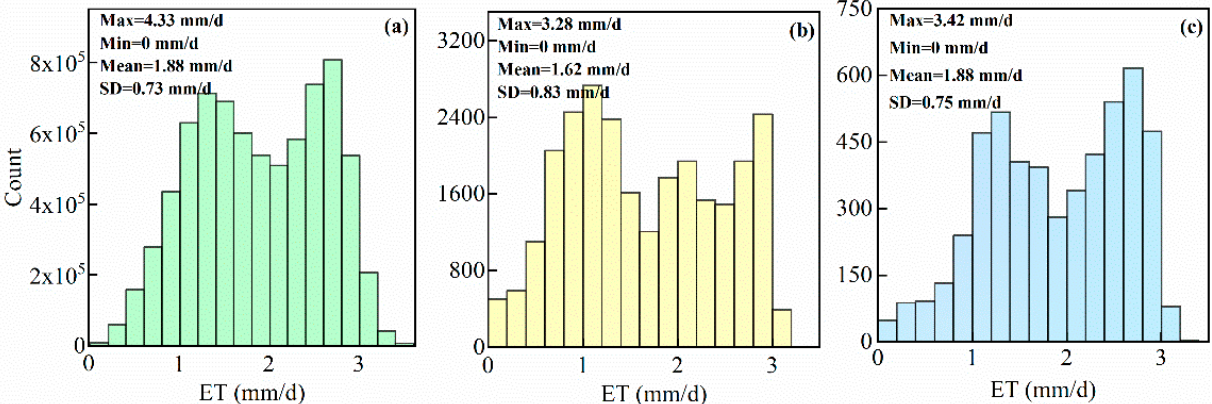
Figure 5. Frequency distribution and statistics of the ET estimates from ( a ) Landsat TM, ( b ) MODIS and ( c ) AVHRR.